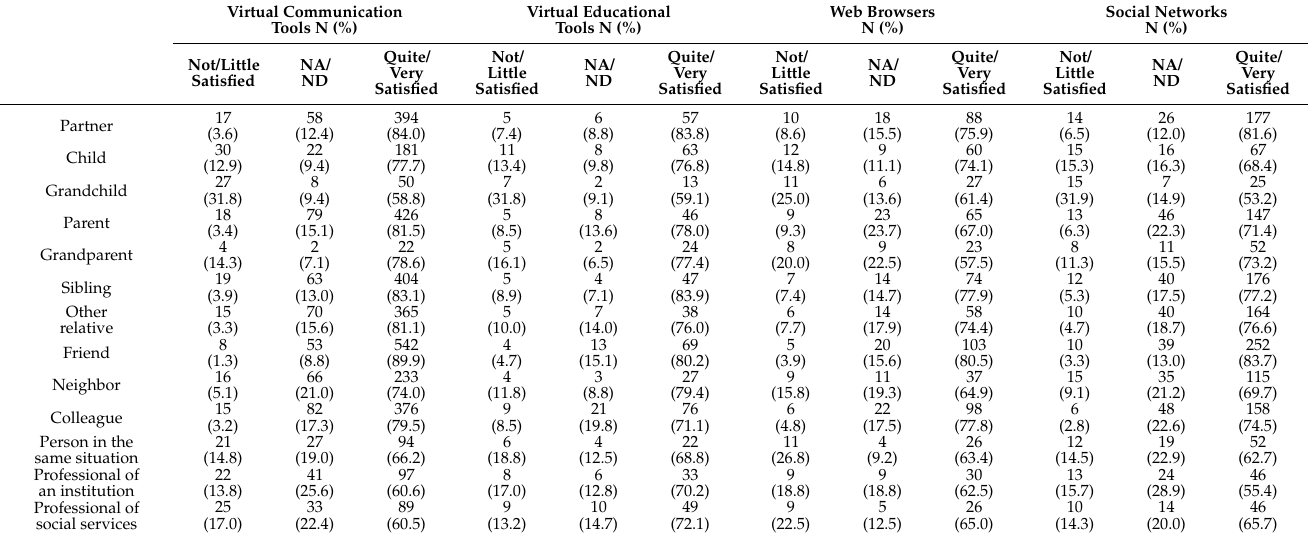
Table 5. Level of satisfaction reported by participants who performed intergenerational virtual activities.